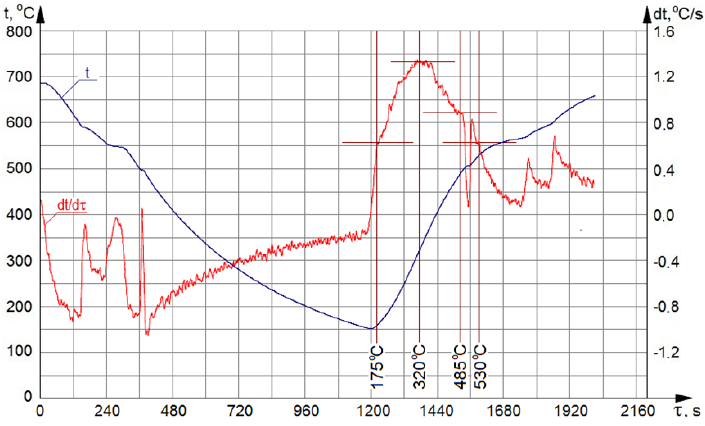
Figure 2. DTA curves for the investigated alloy.